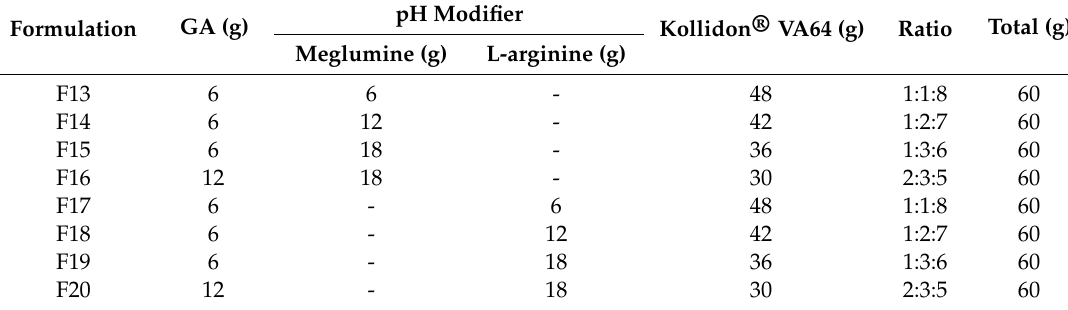
Table 2. Formulation compositions of SD powders (F13–F20).